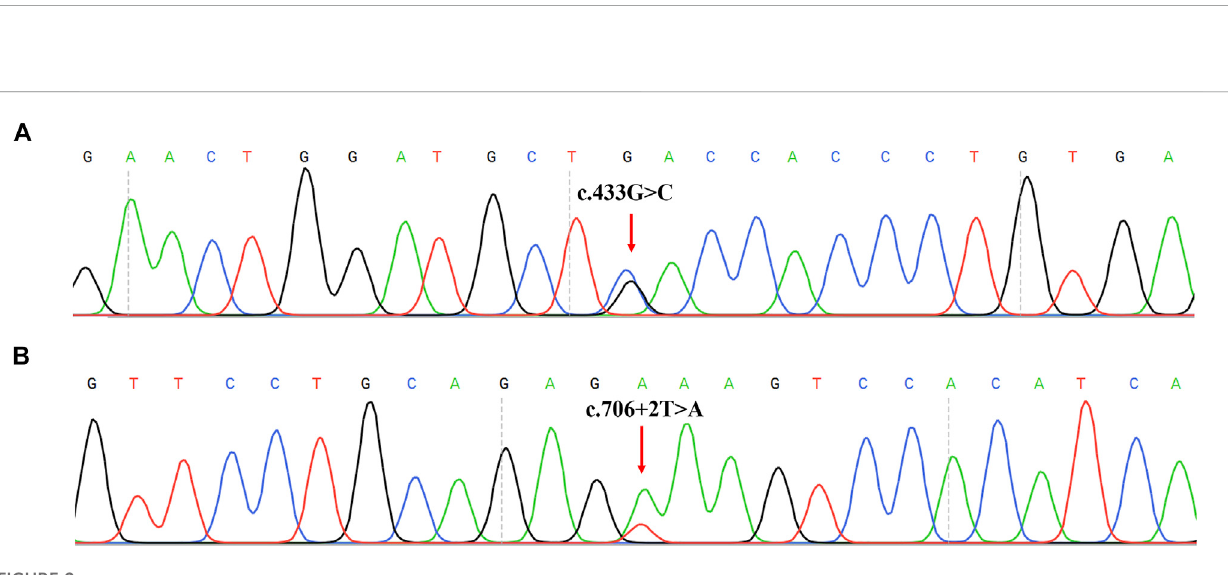
FIGURE 2 Twonovel mutations identi fi edin123 PAHDpatients. (A) Sangersequencingresults ofthec.433G > C mutation on the PAH forward sequence. (B) Sanger sequencing results of the c.706 + 2T > A mutation on the PAH forward